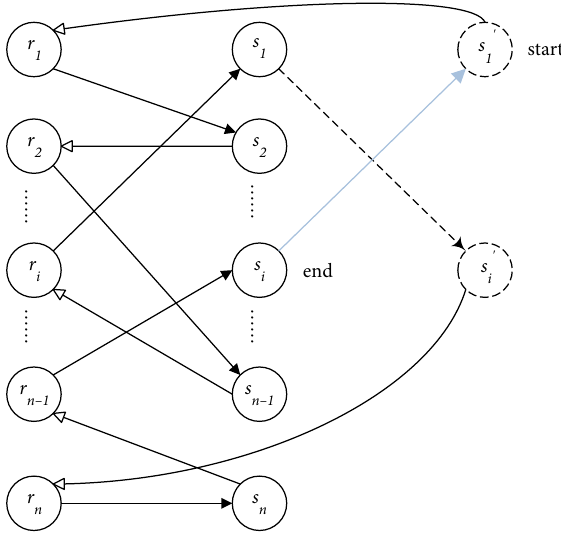
Figure 5: The gantry crane-TSP ∗𝜁 —taking the shortest operation time as the sin-